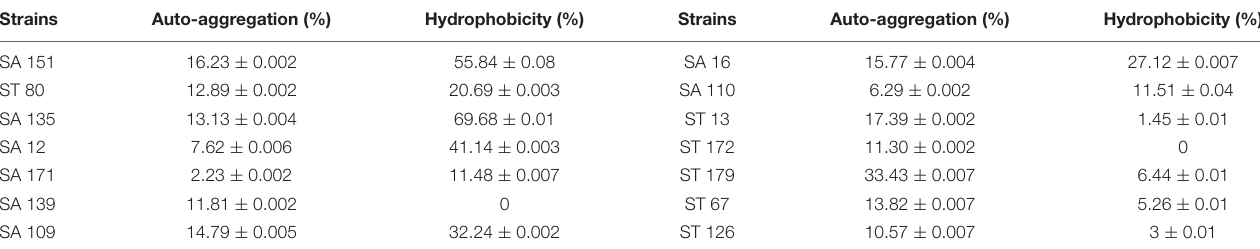
TABLE 7 | Percentage of cell surface hydrophobicity of candidate probiotic strains. Strains Auto-aggregation (%) Hydrophobicity (%) Strains Auto-aggregation (%) Hydrophobicity (%)